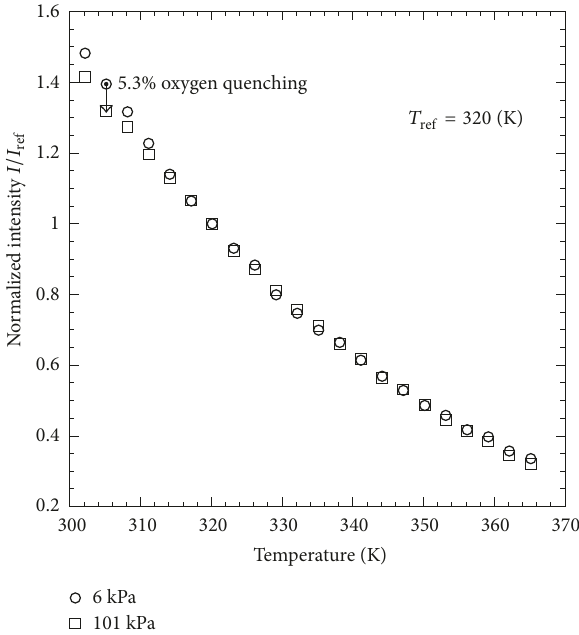
Figure 8: Pressure-sensitivity of temperature sensitive paint.